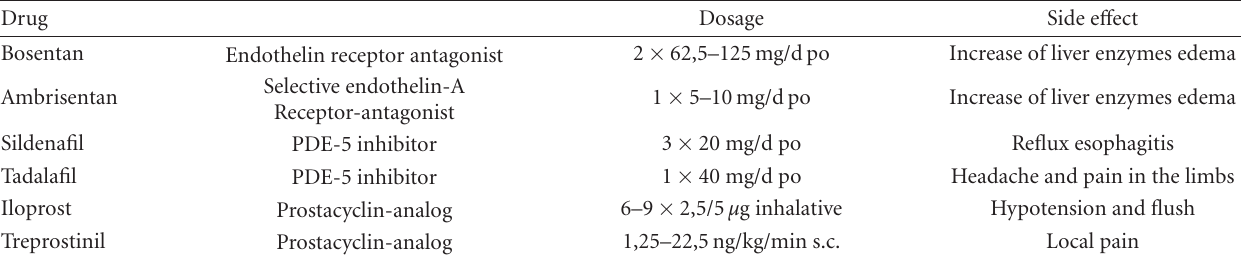
Figure 1: Development of right-ventricular failure in patients with pulmonary hypertension. Table 4: Therapy of pulmonary hypertension: approved drugs (mod.